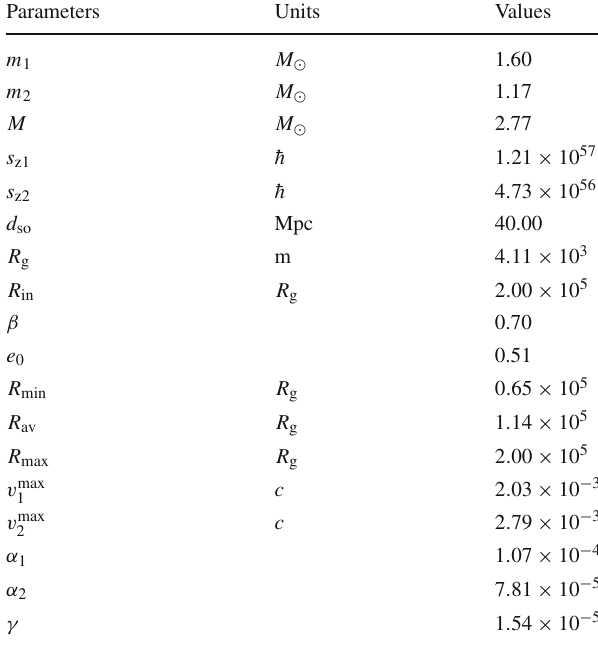
Table 1 List of parameters of the binary NS system analyzed in Sect. 5.3.2